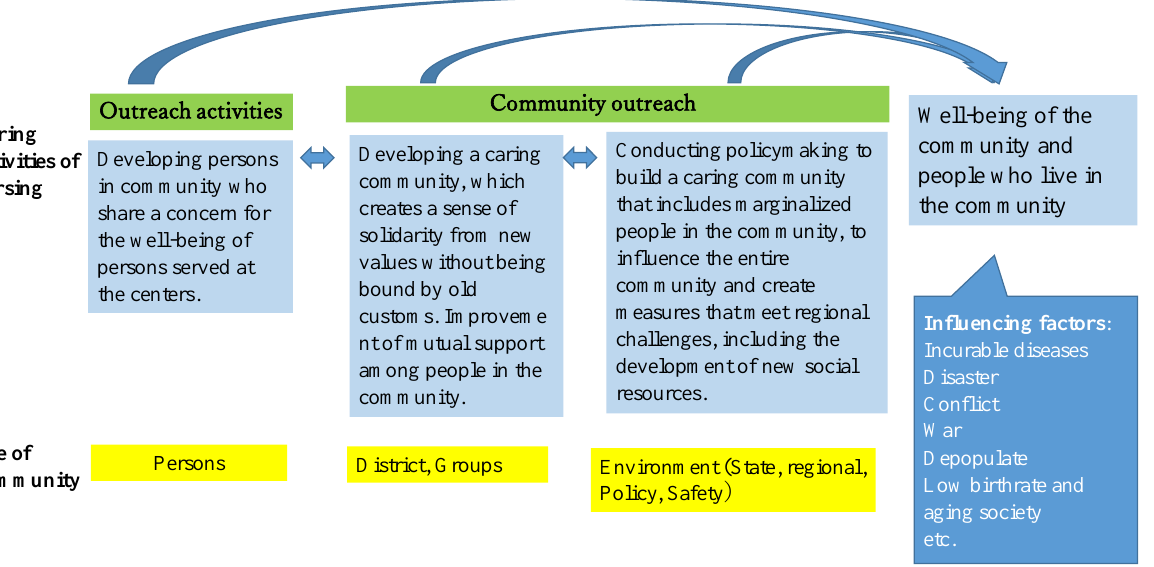
Figure 2. The model of the caring activities of nursing in the theory of community caring for public health nurses.